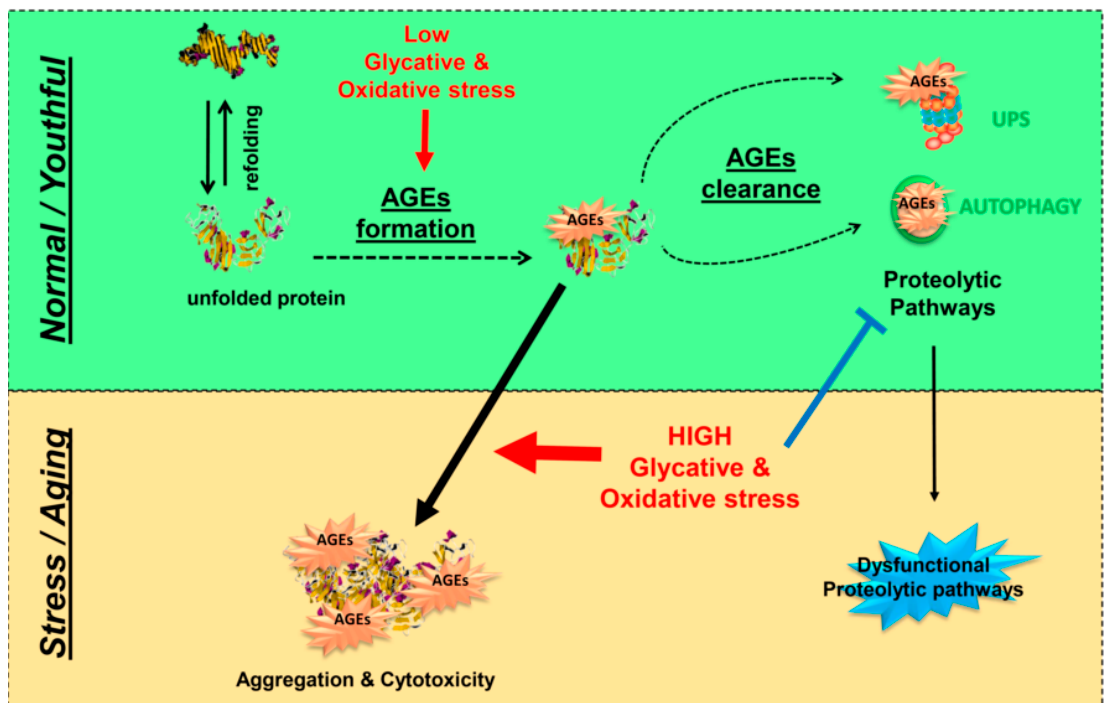
Figure 4. Proteolytic pathways are the last line of defense against AGE-derived proteotoxicity. Under homeostatic conditions (green box), different proteolytic pathways (UPS and autophagy) act to avoid the accumulation of toxic AGEs. Under high levels of glycative and oxidative stress and/or aging (orange box), the production of AGEs is boosted and tissue fitness is compromised as result of glycation-derived protein aggregation and cytotoxicity. Proteolytic capacities are insufficient to lower AGEs levels because of age-related changes in UPS and autophagy along with the inhibitory effect of glycative stress on proteolytic function.